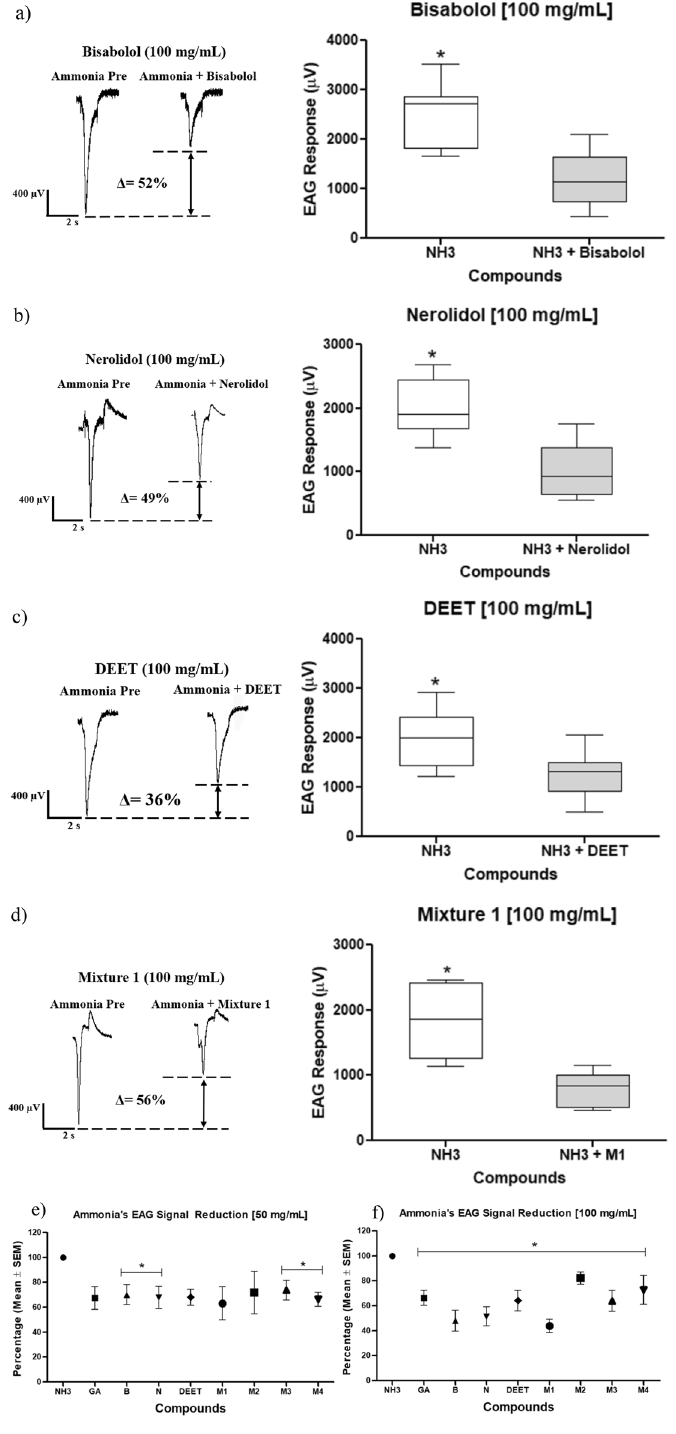
Figure 5. Electroantennography signal patterns and percentage changes in the electrical signals after applying the ammonia and the repellent stimulus simultaneously. ( a ) α-bisabolol 100 mg/mL, ( b ) Nerolidol 100 mg/ mL, ( c ) DEET 100 mg/mL and ( d ) Mixture 1 [100 mg/mL]. The ammonia-repellent stimulus was applied after an initial pulse containing only ammonia. (*) Indicates statistically significant differences between the pre- treatment ammonia stimulus in comparison with the ammonia-repellent stimulus. One way ANOVA, t-student test, α-bisabolol) 100 mg/mL (t(6) = 4231; p = 0.0055, t-test); Nerolidol 100 mg/mL (t(7) = 5129; p = 0.0014, t-test); DEET 100 mg/mL (t(7) = 2883; p = 0.0236, t-test); mixture 1 [100 mg/mL] (t(6) = 5824; p = 0.0011, t-test). ( e ) and ( f ) Percentual reduction EAG signal summary regarding the exposition to the molecules and mixtures in the 50 mg/mL and 100 mg/mL concentration, respectively. (NH 3 : ammonia, GA: geranyl acetate, B: α-bisabolol, N: nerolidol, DEET, M1: mixture 1, M2: mixture 2, M3: mixture 3, M4: mixture